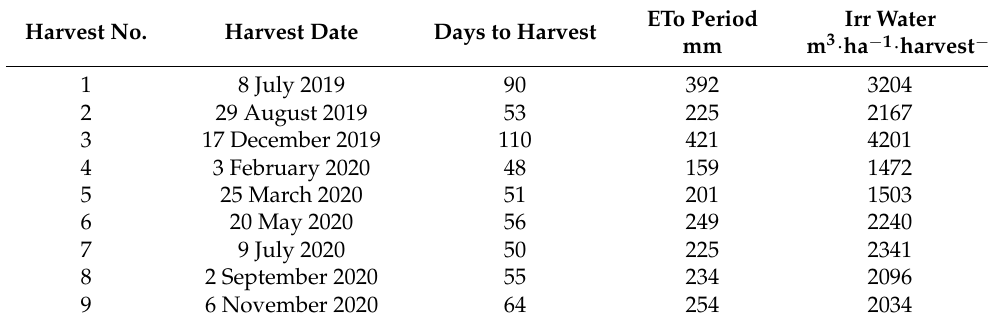
Table 1. Harvest number, harvest date, growing period (days), ETo for each period (mm), and irrigated water volumes added by period (m 3 · ha − 1 · harvest − 1 ). Harvest